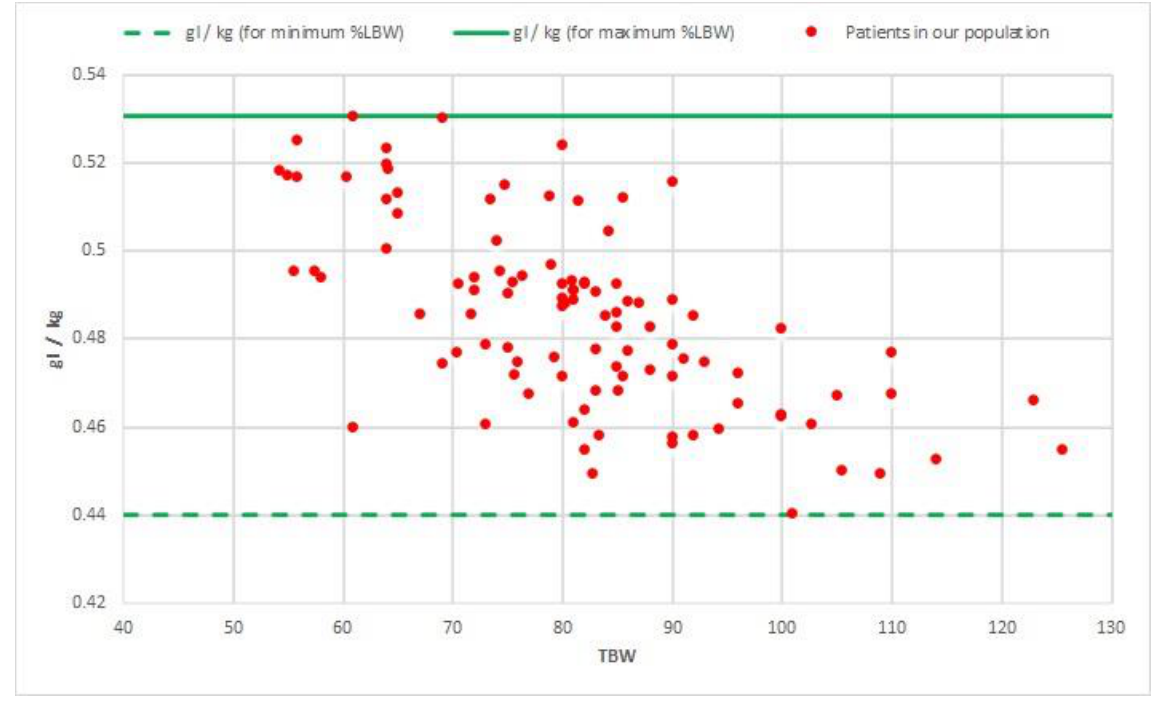
Figure 4. Analysis of future contrast applications: grams of iodine (gI) per kilogram (kg) TBW in the LBW formula; grams of iodine per kilogram of TBW (total body weight) in the LBW (lean body weight) formula for the population of our study. The grams of iodine per kilogram of TBW all lay between the patient with the maximum LBW (iodine (gr) maximum LBW/kg) and the patient with the lowest LBW (iodine (gr) minimum LBW/kg). Herein, the highest spreads were found in the ≤70 kg and 70–90 kg weight groups.